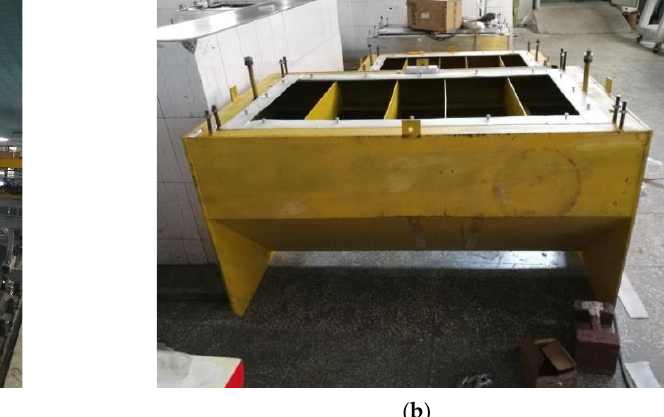
5 of 34 Table 2. Coordinate position of measurement point. Point